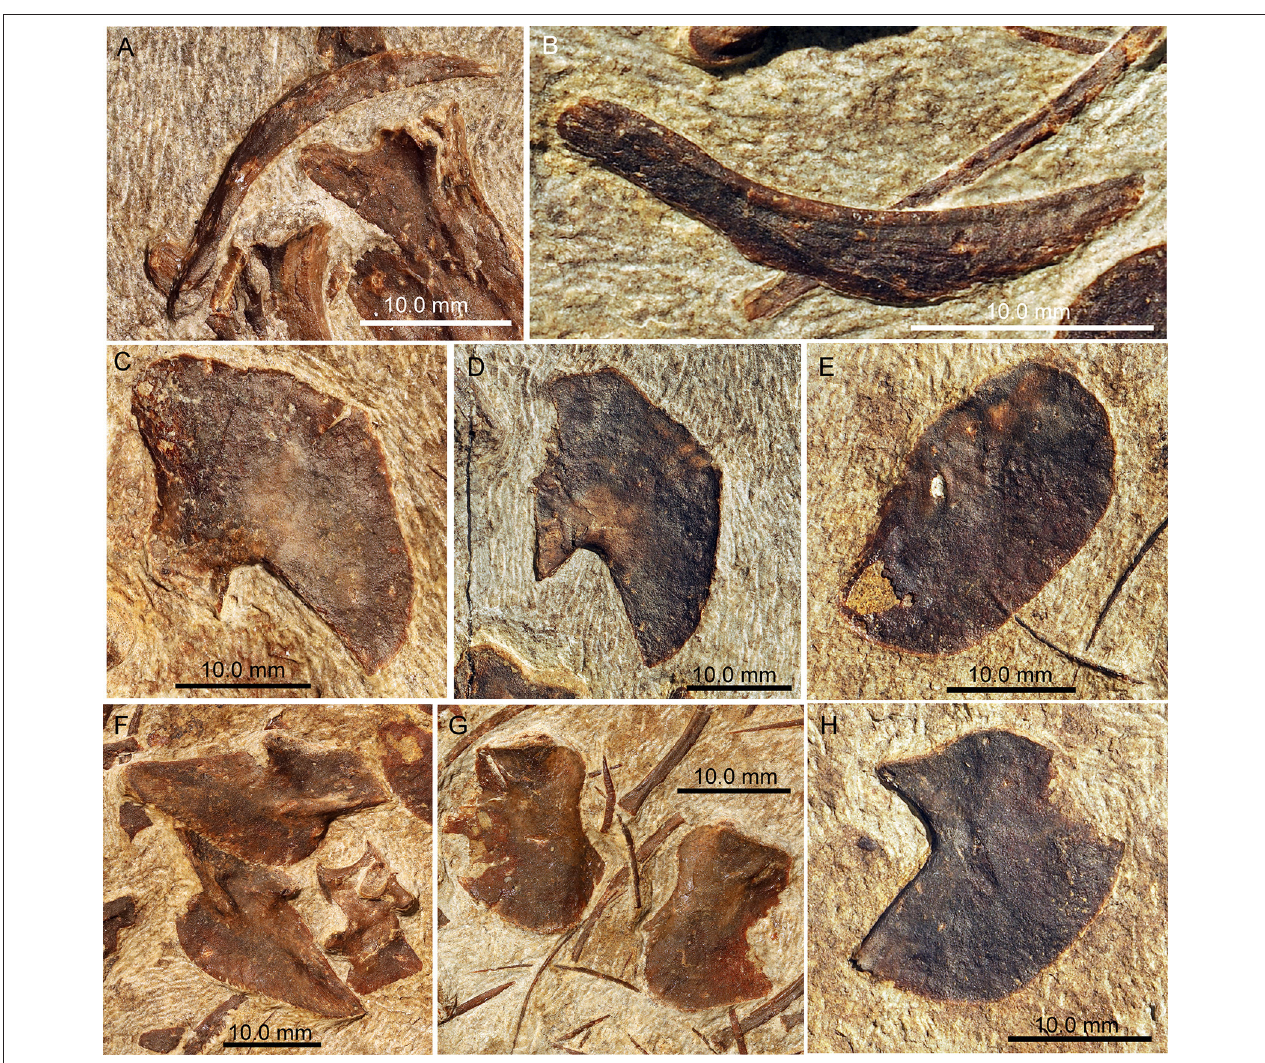
FIGURE 8 | Photographs of selected girdle elements of PIMUZ T 1559. (A) Left clavicle in anterior view; (B) right clavicle in angled anterior view; (C) left scapula in lateral view; (D) right scapula in medial view; (E) right coracoid in medial view; (F) ilia in lateral view; (G) pubes in lateral view; (H) left ischium in lateral view.